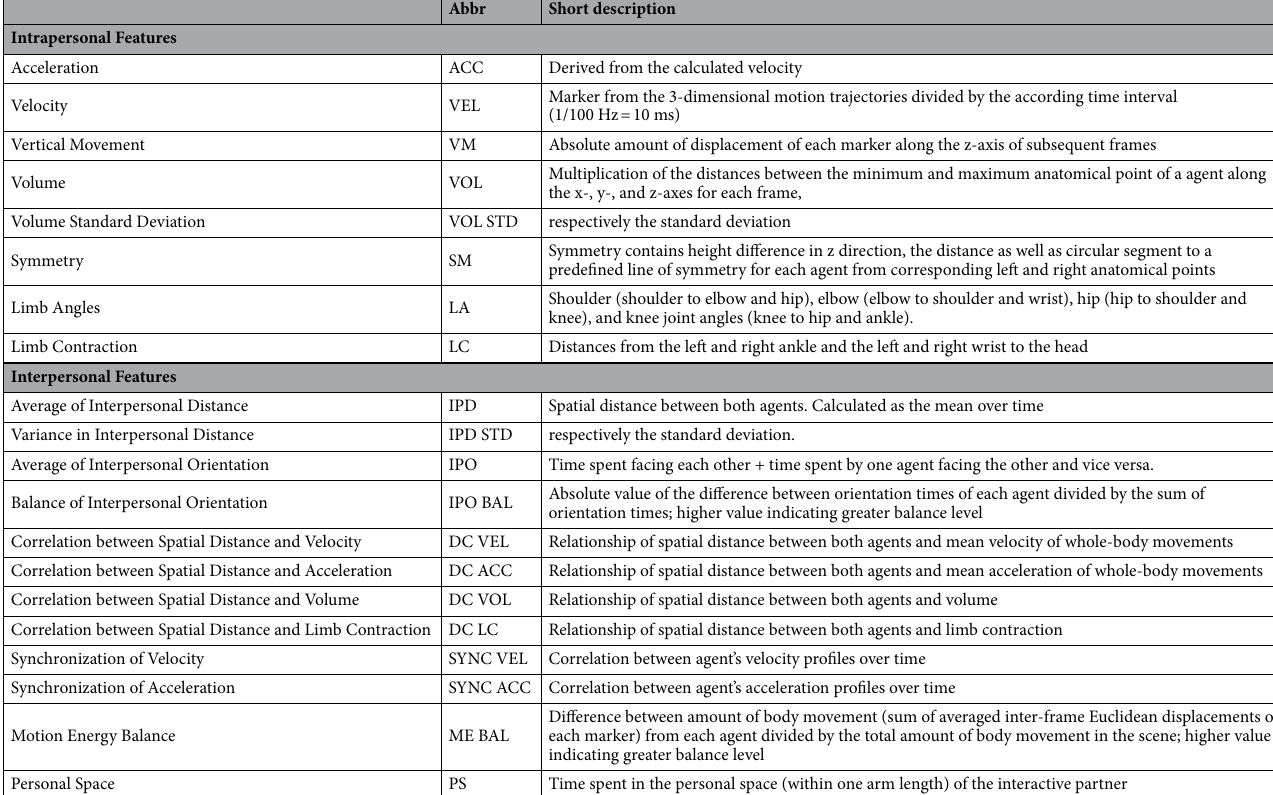
Table 1. Summary of interaction-specific intrapersonal and interpersonal features calculated with the SAMI toolbox 35 . For a detailed explanation, see supplementary